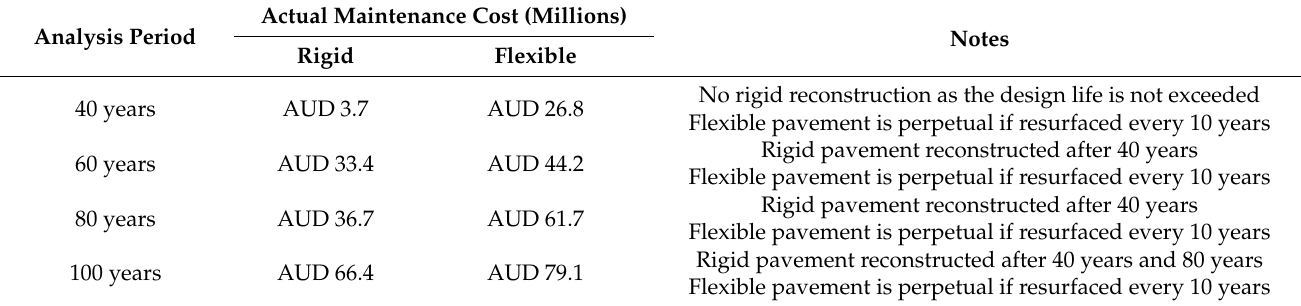
Table 8. Estimated maintenance